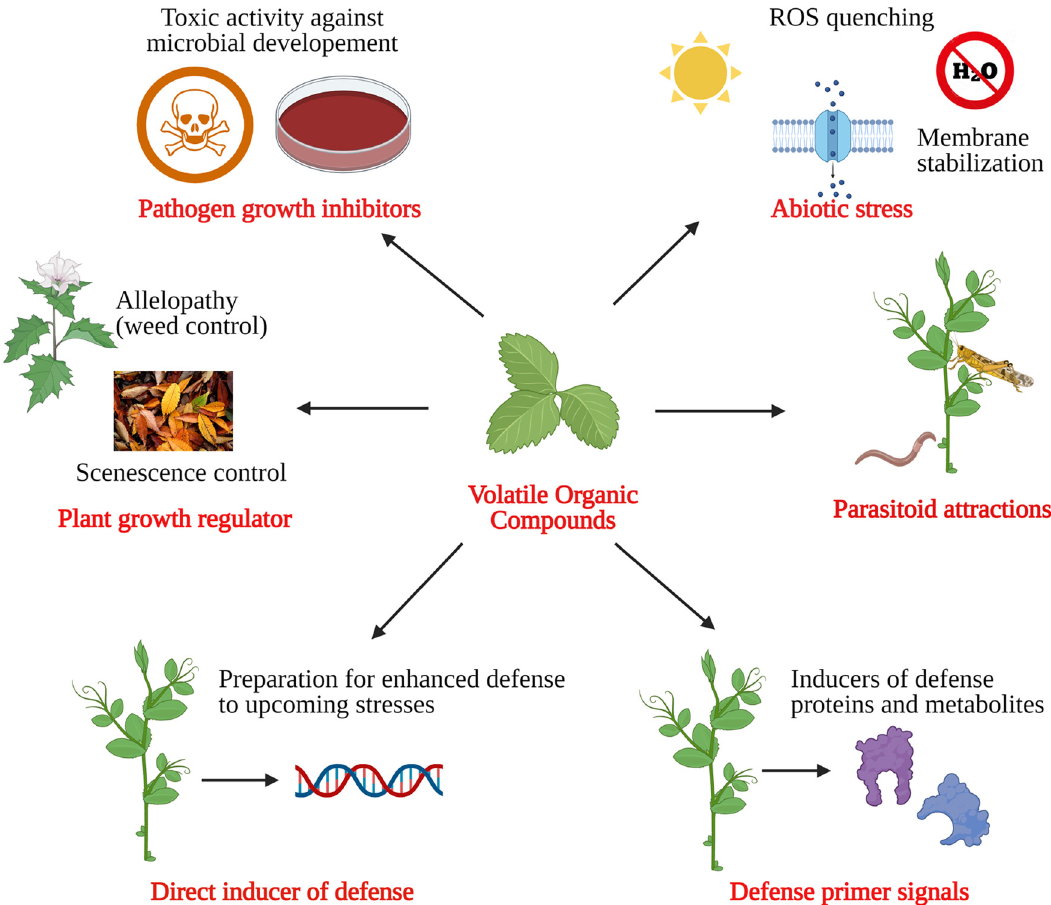
Figure 2: Role of VOCs for di ff erent plant signal